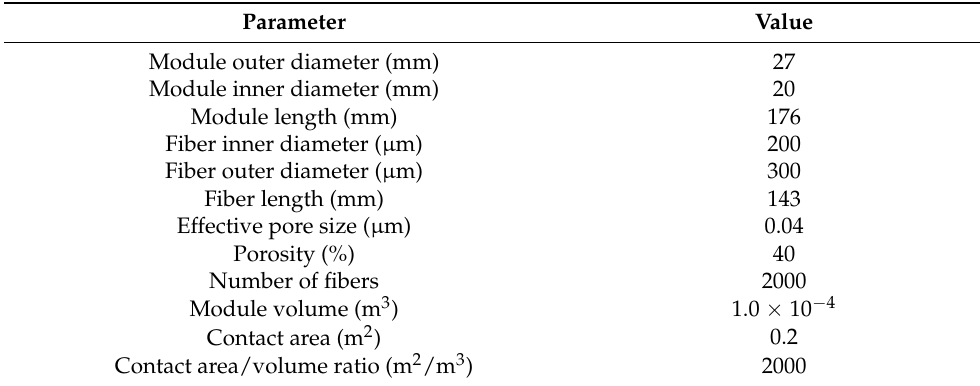
Table 1. Specifications of the hollow fiber membrane contactor module (3M Liqui-Cel™ MM-1 × 5.5